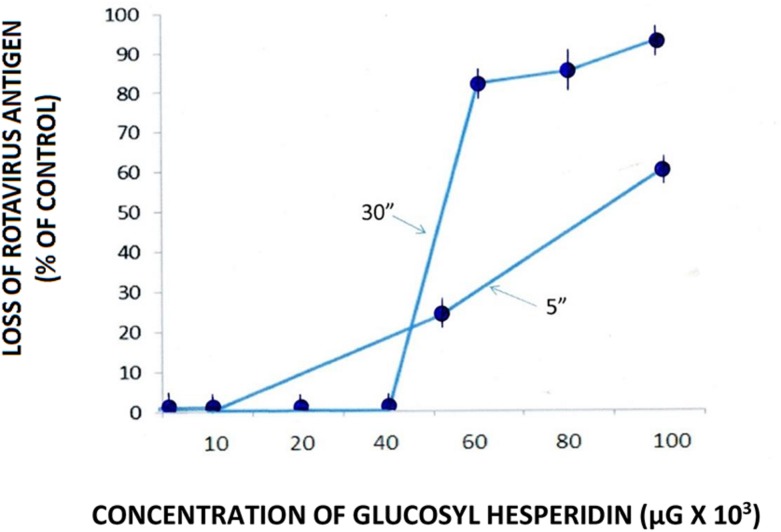
Effect of glucosyl hesperidin (GH) on the loss of rotavirus (RTV) antigen in cell-free suspension. RTV/GH complexes were maintained for 5 and 30 min. at room temperature (23°C) followed by the quantitative measurement (using qEIA) of the VP6 capsid antigen. Data points from spectrophotometric readings represent the mean ± SE of the means. P < 0.05 is assumed statistically significant.